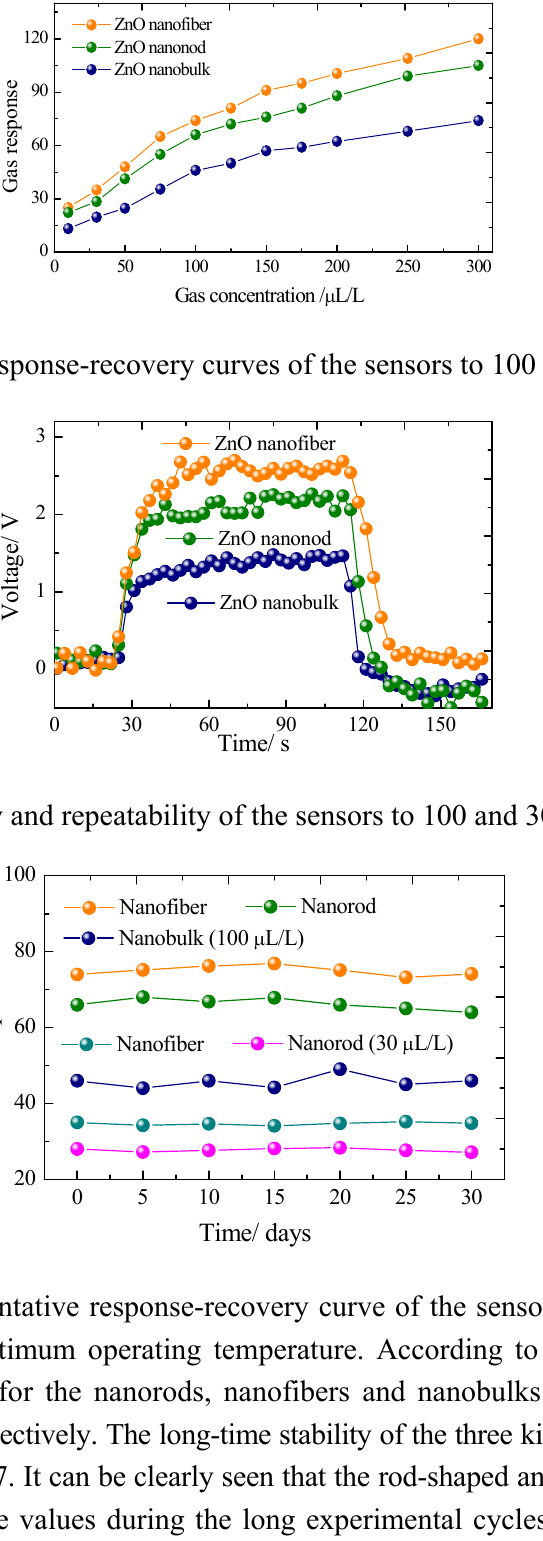
Figure 5. Gas response of the sensors to different concentration ranking from 10 to 300 µL/L.